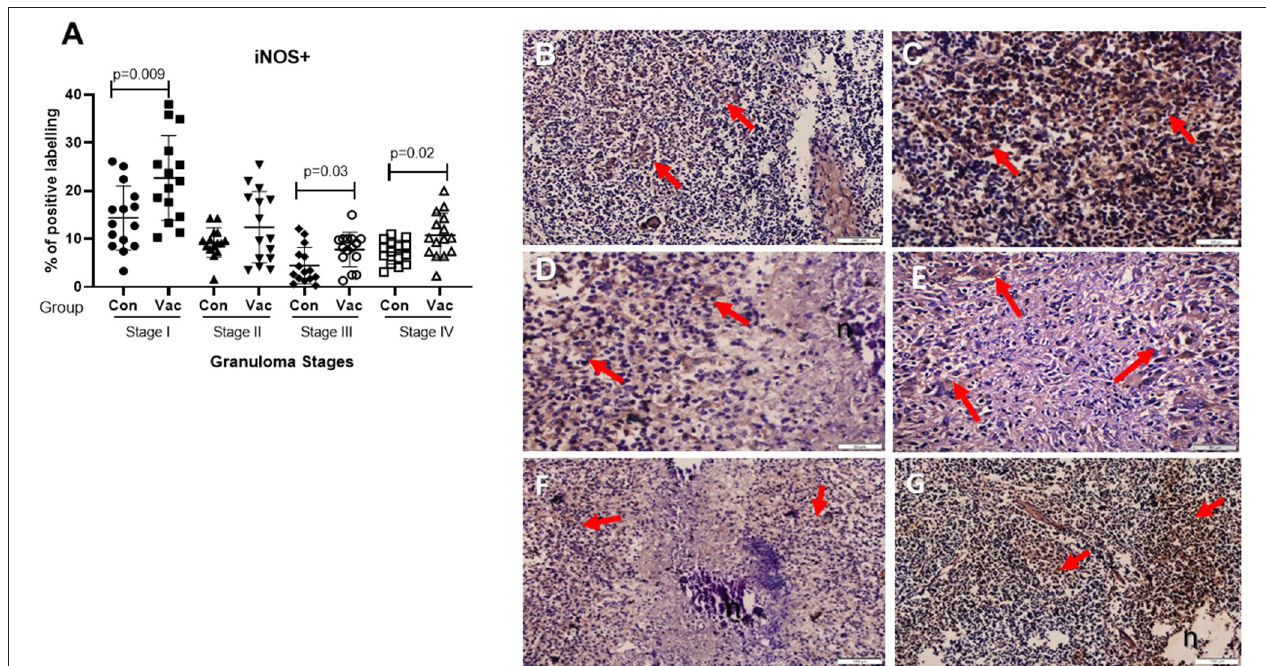
FIGURE 6 | Immunolabelling for iNOS + . (A) Comparison of iNOS + cell distribution in different granuloma stages of BCG vaccinated (Vac) and non-vaccinated (Con) calves. (B) Stage I granuloma from non-vaccinated calf with some iNOS + positively stained cells (arrows). (C) Stage I granuloma from BCG vaccinated calf, many cells stained for iNOS + (arrows). (D) Stage III granuloma from non-vaccinated calf showing stained cells with iNOS + (arrows). (E) Stage III granuloma showing cells stained positively with iNOS + from BCG vaccinated calf (arrows). (F) Stage IV granuloma from non-vaccinated calf showing cells stained with iNOS + (arrows). (G) Stage IV granuloma from BCG vaccinated calf showing many cells stained with iNOS + (arrows). Bar equals in (B,C) 50 µ m, Bar equals 100 µ m (D–G) . n, necrotic